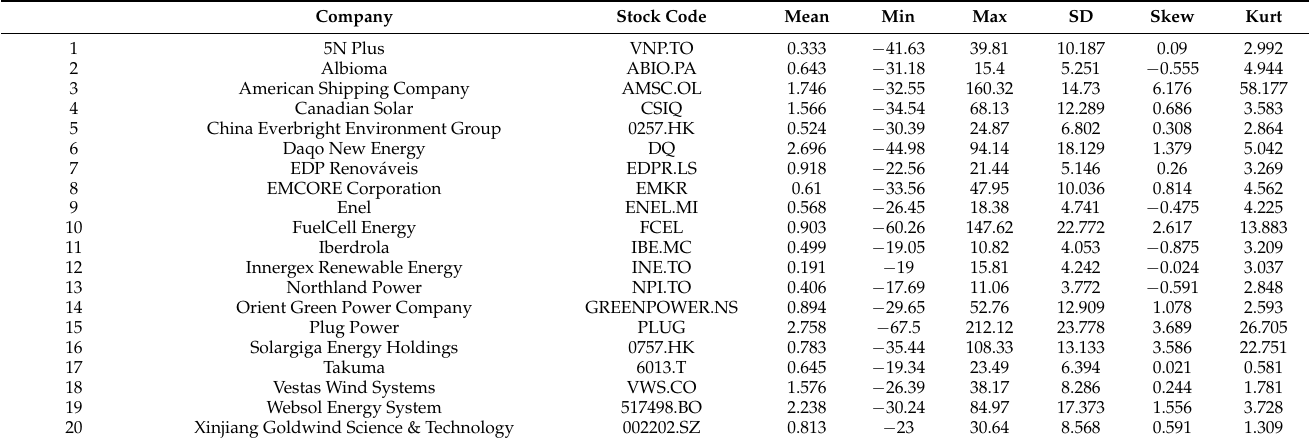
Table 1. Sample companies and statistics for 10-day nonoverlapping